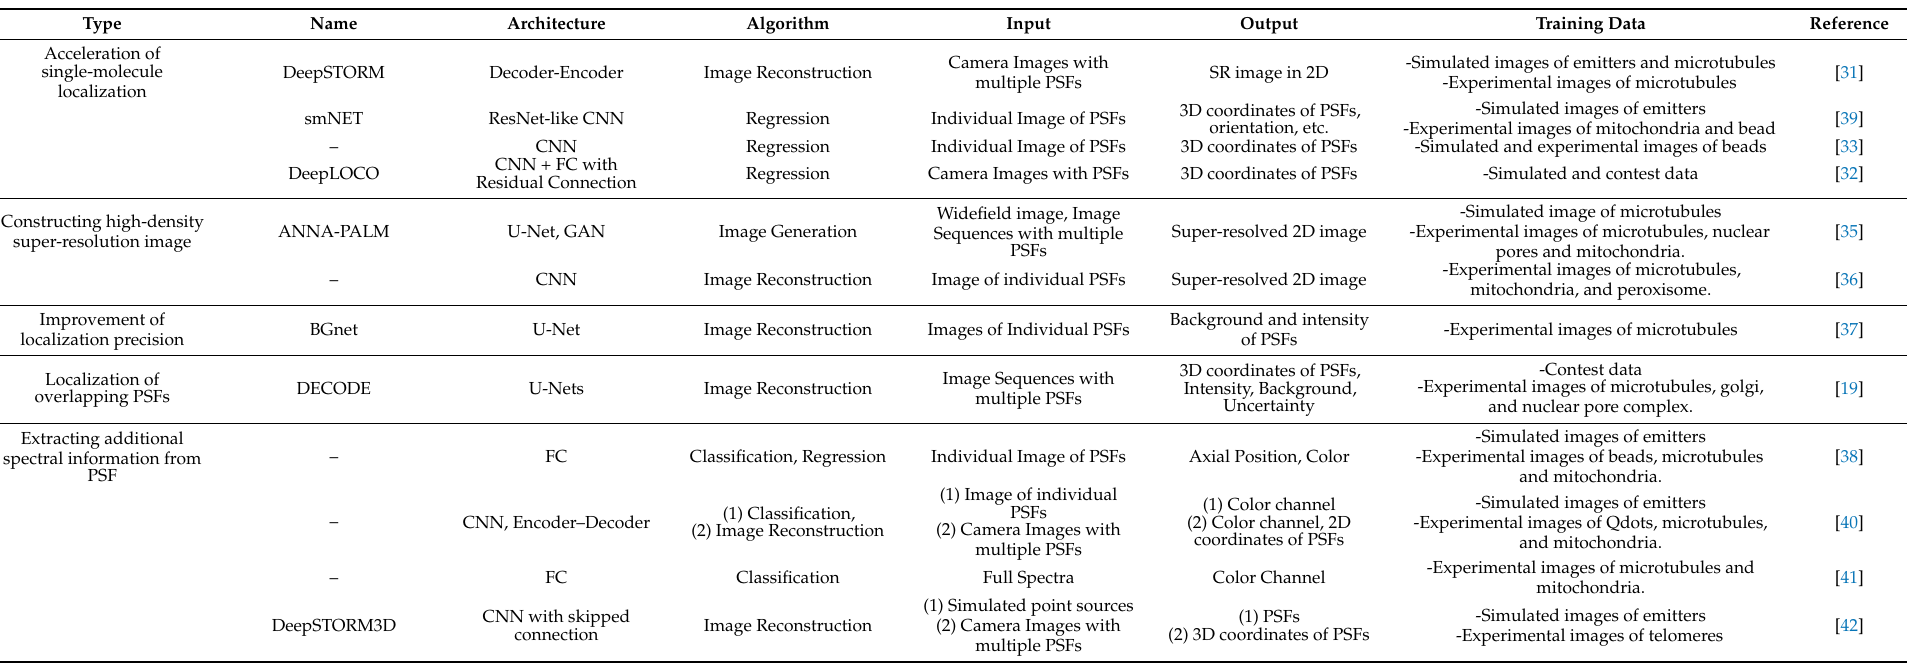
Table 1. Comparison of reported studies on the deep-learning-based single-molecule localization image